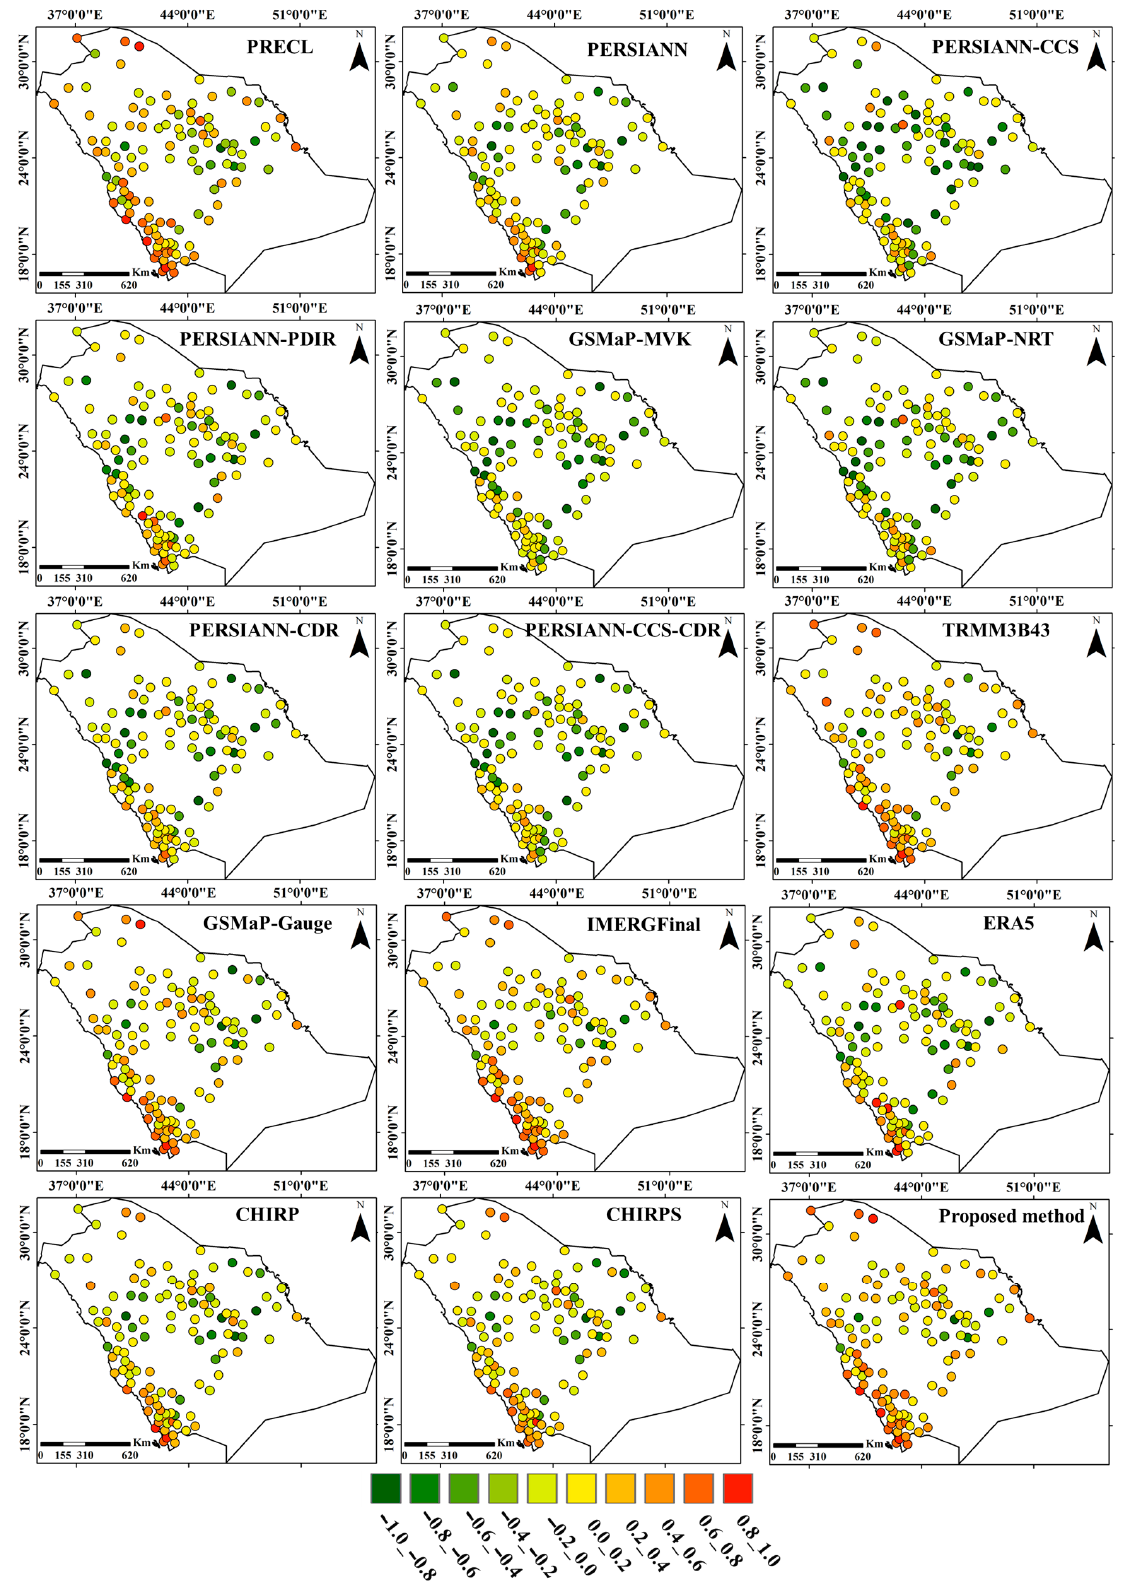
Figure 6. Spatial distribution of KGE for the precipitation datasets in geographical location of validation stations based on point-to-pixel strategy. The KGE boxplot for precipitation products at the ground station scale is shown in Figure 7. The KGE range for IMERGFinal, GSMaP-Gauge, TRMM3B43, CHIRP, CHIRPS and PRECL products is lower than other products. The highest range of KGE values is for